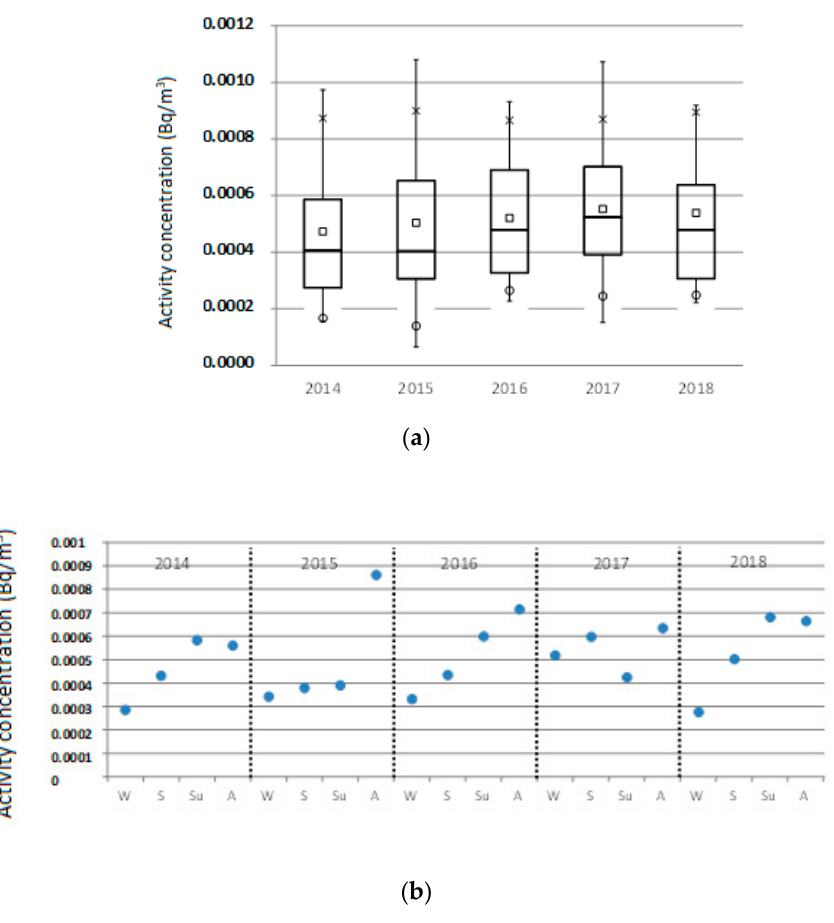
Figure 9. ( a ) Year-to-year variability and ( b ) seasonal average in the city of Bilbao over five years (2014–2018) for beta activity concentrations. W: winter; S: spring; Su: Summer, A: autumn.